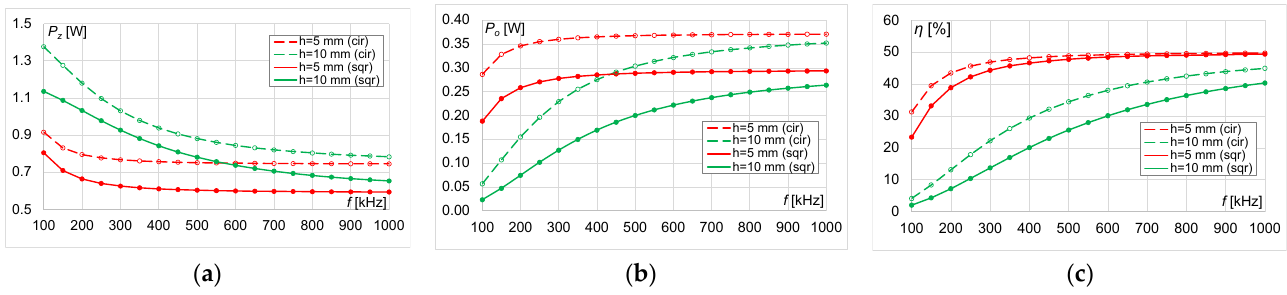
0.81.01.21.41.61.82.02.2